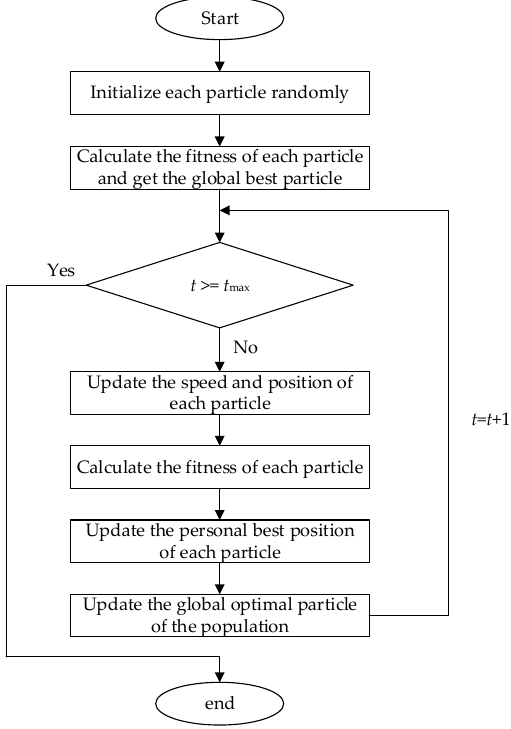
Figure 4. AGV double-cycling algorithm.